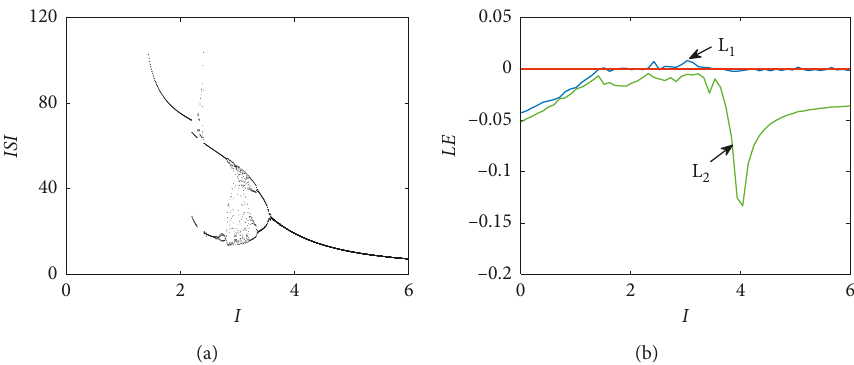
Figure 1: Bifurcation diagram (a) and Lyapunov exponent spectrum (b) of HR neuron with external stimulation current I . The initial values are selected with (0.1, 0.01, 1.05).